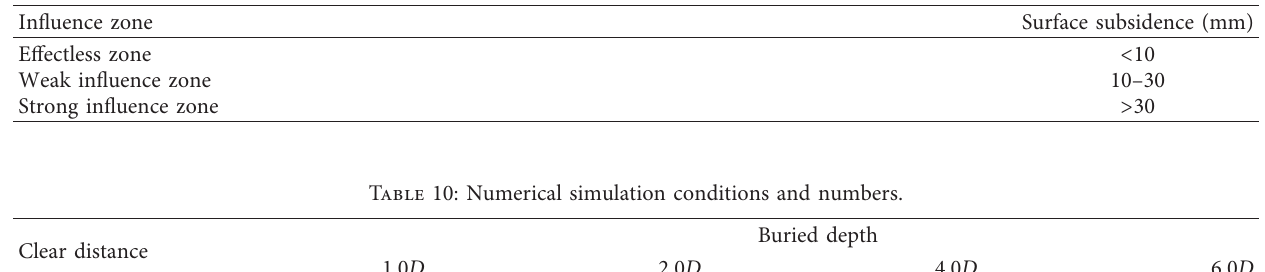
Table 9: Ground settlement criterion discriminant